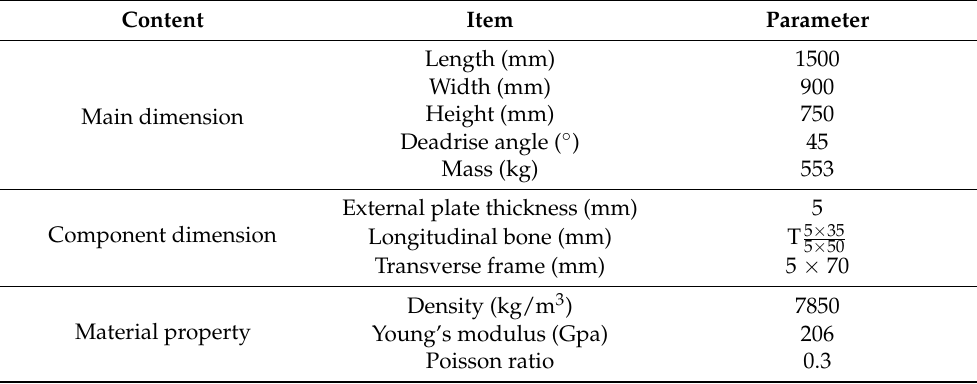
Table 1. Main parameters of the wedge structure and the stiffeners.